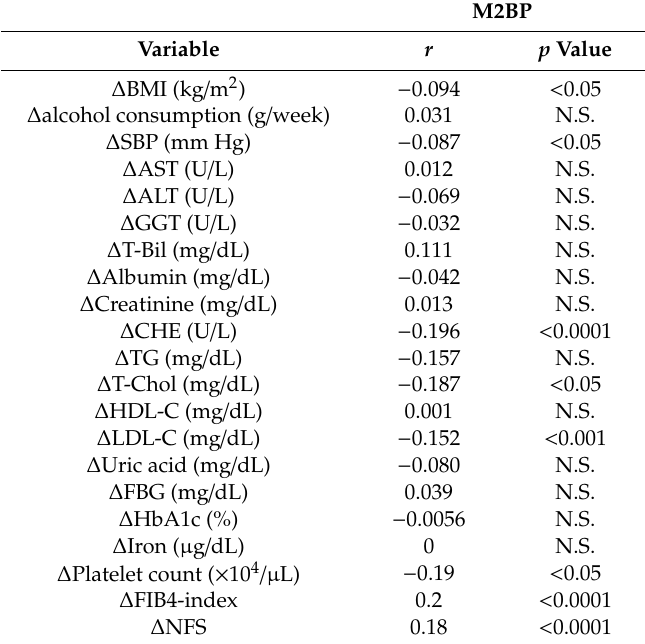
Table 4. Correlations between baseline serum M2BP levels and changes in various parameters.